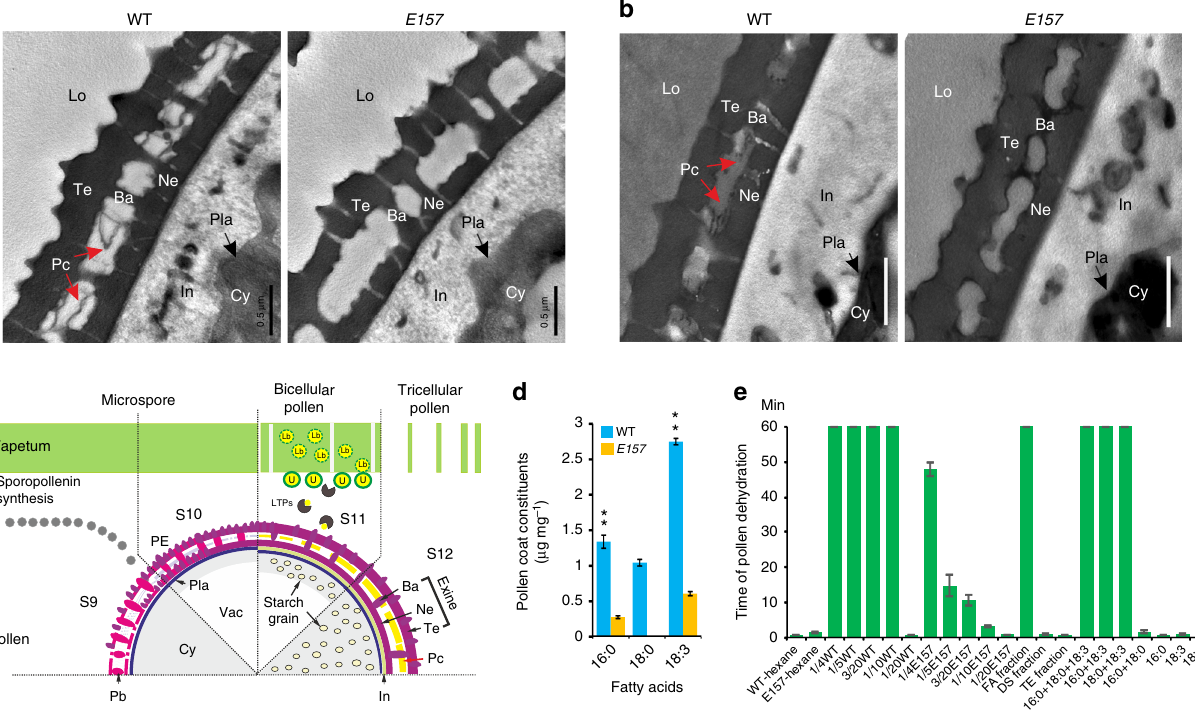
Fig. 4 Identi fi cation of pollen coat chemicals. TEM analysis of ultramicrotome ( a ) and cryo-ultramicrotome ( b ) sections of the WT and E157 pollen wall at S14. c Proposed mode of pollen coat formation during stages S9 to S12. Ba bacula, Cy cytoplasm, In intine, LTPs lipid transfer proteins, Lo locule, Ne nexine, Pc pollen coat (indicated by red arrows), PE primexine, Pla plasma membrane, Te tectum, U ubisch body, Vac vacuole. d Analysis of pollen coat lipids of the WT and E157 plants. The values indicate means ± s.d., n = 5, ** P < 0.01, by Student ’ s t test. e Pollen dehydration rates when treated with pollen coat extracts and chemicals. E157 -hexane: E157 pollen treated by hexane, WT-hexane: wild-type pollen treated by hexane, abbreviates of fraction and chemical names are listed in Supplementary Table 4. Times of pollen ( n = 100 – 150) dehydration are presented in the form of mean ± s.d., n = 3. Scale bar, 0.5 μ